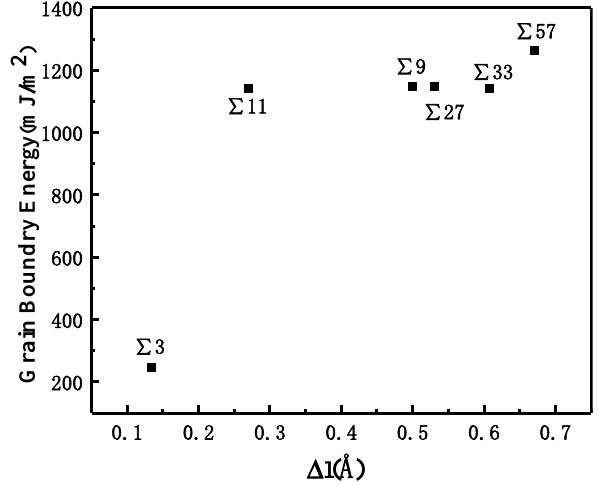
ff erent symmetric GBs.